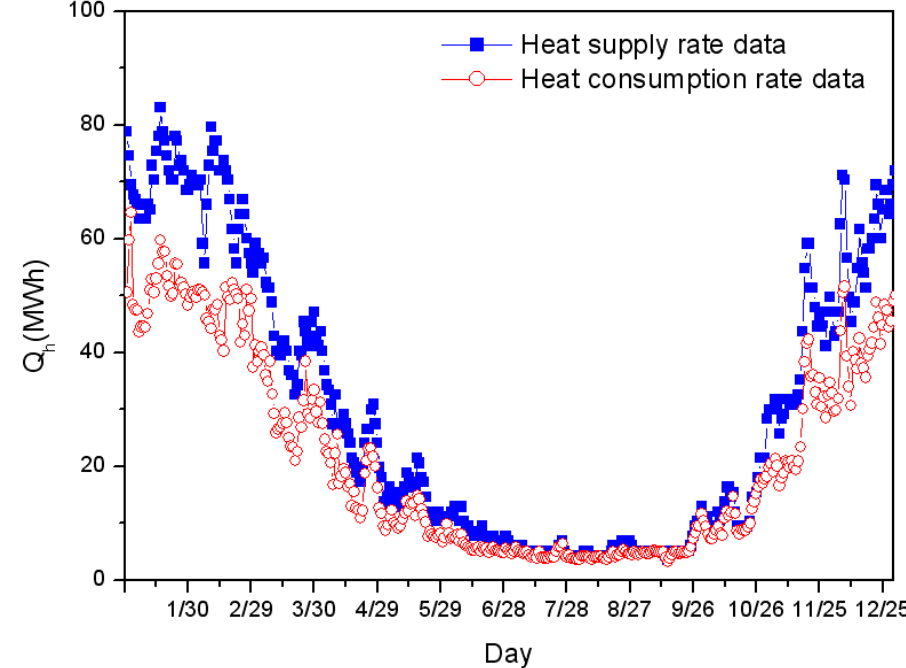
Figure 5. Annual variations of heat supply and use rates of the model apartment.